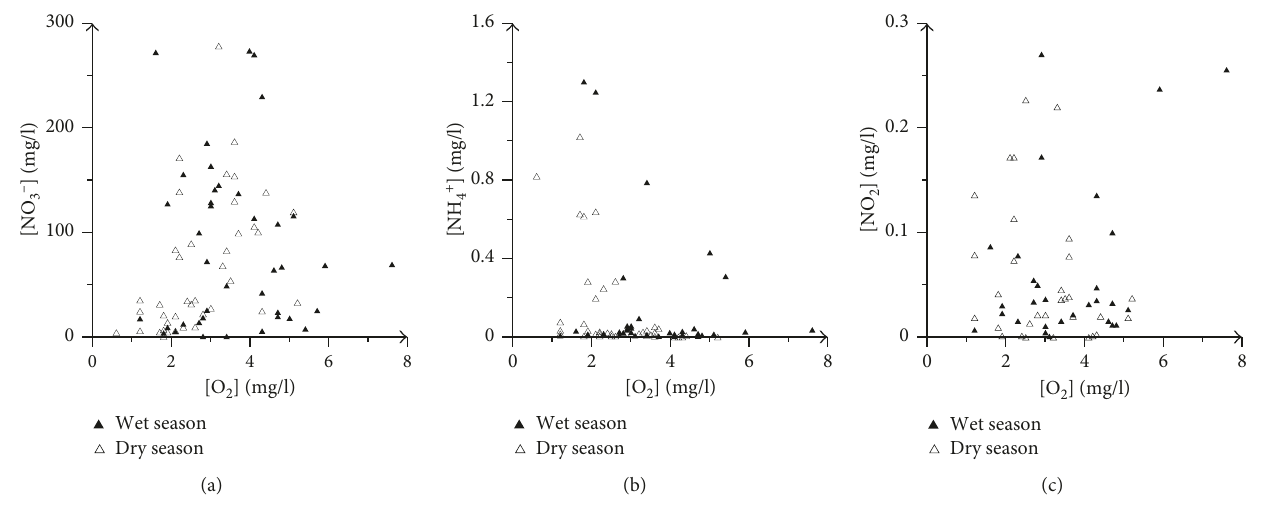
Figure 14: Bivariate pot of O